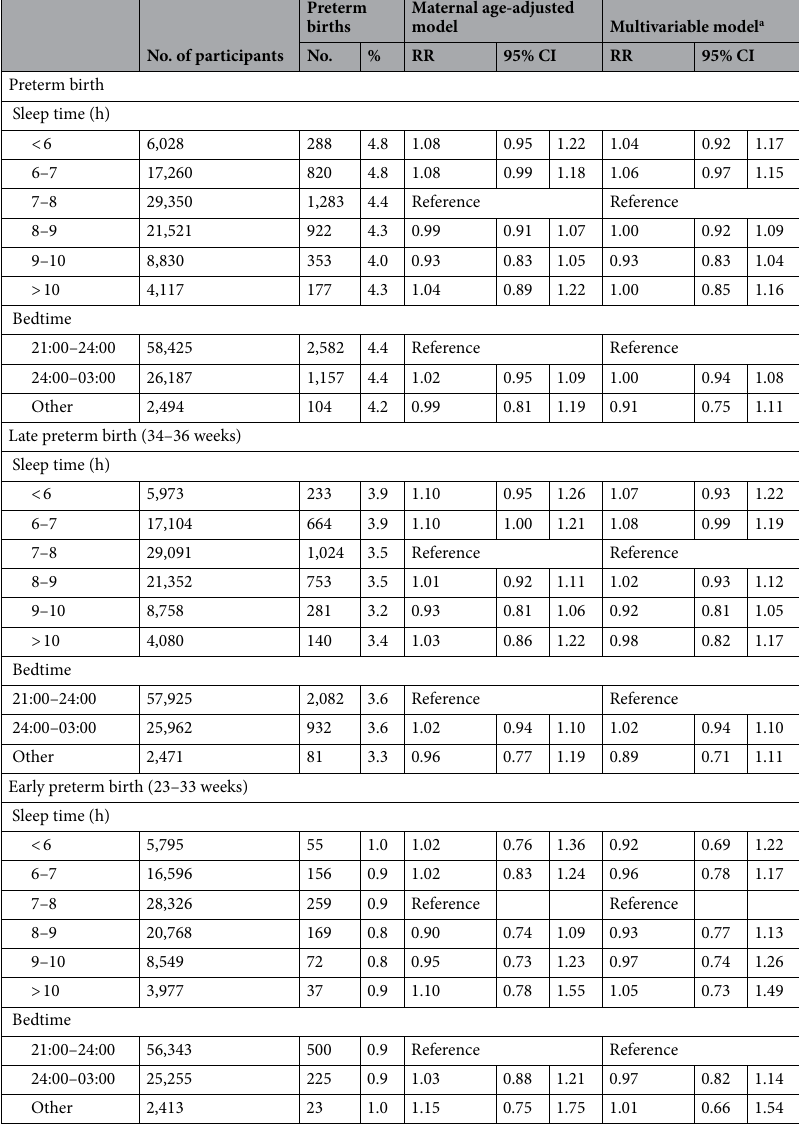
(n = 1,427), congenital anomaly identified by 1 month old (n = 3,554), missing information on maternal age at delivery (n = 5), and no response to the questions related to sleep at both M-T1 and M-T2 (n = 983). The remain- ing 88,254 participants (87,106 with M-T1 data and 86,358 with M-T2 data) were included in the analysis of the association between maternal sleep and preterm birth. Then, we further excluded preterm or post-term deliveries (n = 4,113) and participants who did not respond to the questions related to the children’s sleep and temperament at M-1m (n = 1,307). (Fig. 1) Finally, 81,821 participants with M-T1 data and 82,038 participants with M-T2 data were included in the analysis of the association between maternal sleep and infant sleep and temperament.